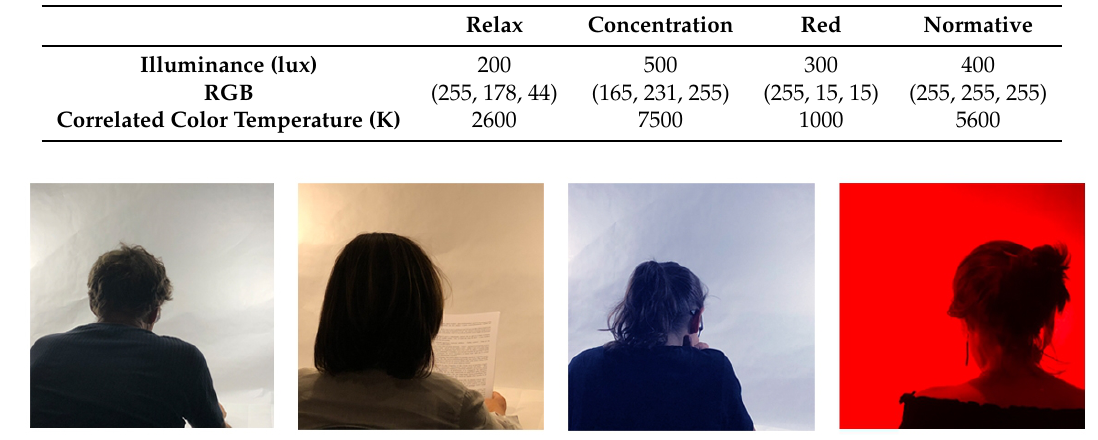
Table 2. Characteristics of the four light conditions used for the validation. RGB (Red, Green and Blue) is the color model adopted.